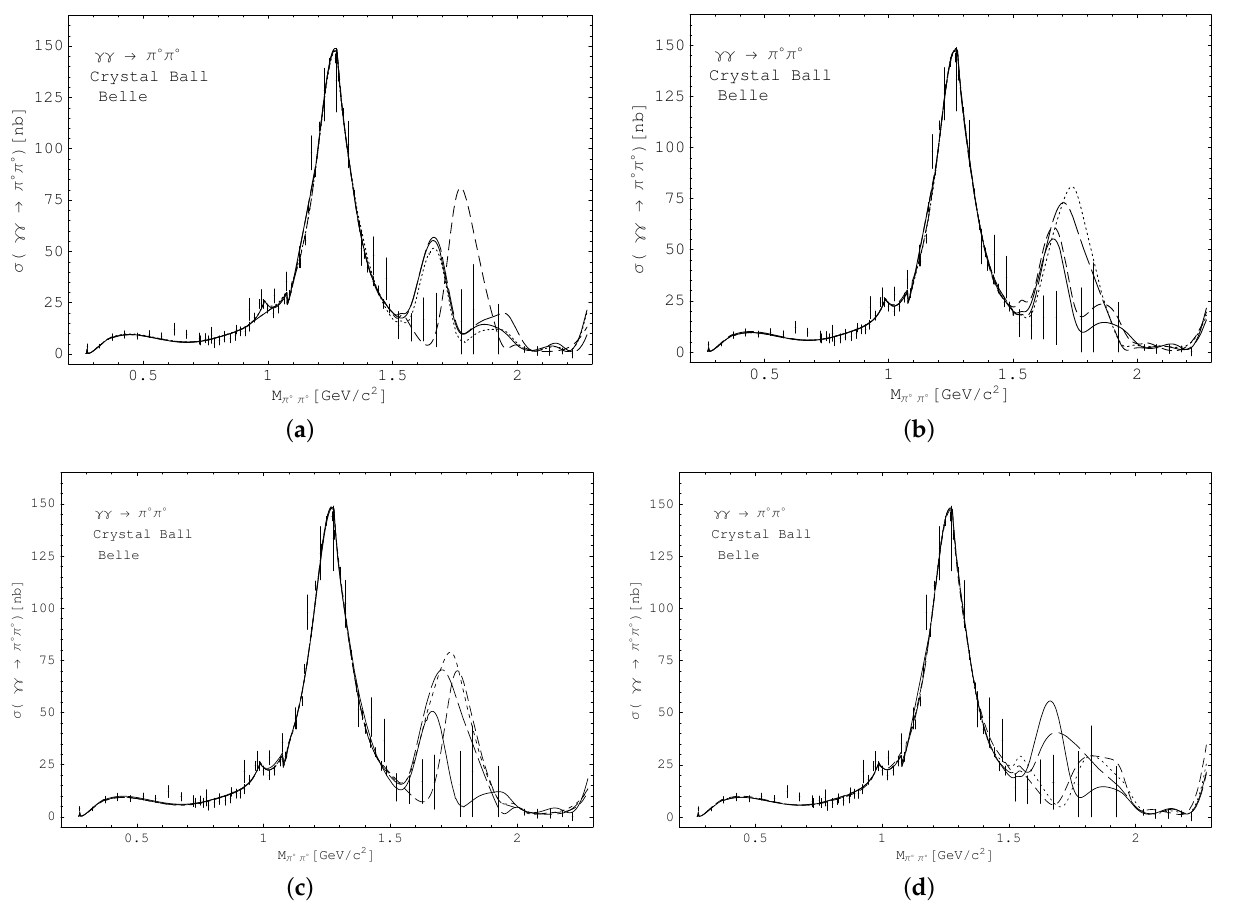
Figure 2. Results for the cross section of the γγ → π 0 π 0 for different scenarios when relevant tensor mesons ( f 2 -resonances) are switched off from the analysis. ( a ): Comparison of the scenarios: (1) full result with taking into account of all involved f 0 - and f 2 -resonances (solid line); (2) f 2 ( 1450.5 ) state is excluded (dotted line); (3) f 2 ( 1601.5 ) state is excluded (short-dashed line); (4) f 2 ( 1534.7 ) state is excluded (long-dashed line). ( b ): Comparison of the scenarios: (1) full result with taking into account of all involved f 0 - and f 2 -resonances (solid line); (2) f 2 ( 1719.8 ) state is excluded (dotted line); (3) f 2 ( 2202 ) state is excluded (short-dashed line); (4) f 2 ( 1760 ) state is excluded (long-dashed line). ( c ): Comparison of the scenarios: (1) f 2 ( 1450.5 ) and f 2 ( 1534.7 ) states are excluded (solid line); (2) f 2 ( 1534.7 ) and f 2 ( 1719.8 ) states are excluded (dotted line); (3) f 2 ( 1534.7 ) and f 2 ( 1601.5 ) states are excluded (short-dashed line); (4) f 2 ( 1534.7 ) and f 2 ( 1760 ) states are excluded (long-dashed line). ( d ): Comparison of the scenarios: (1) full result with taking into account of all involved f 0 - and f 2 -resonances (solid line); (2) f 2 ( 1601.5 ) and f 2 ( 1719.8 ) states are excluded (dotted line); (3) f 2 ( 1601.5 ) and f 2 ( 1760 ) states are excluded (short-dashed line); (4) f 2 ( 1719.8 ) and f 2 ( 1760 ) states are excluded (long-dashed